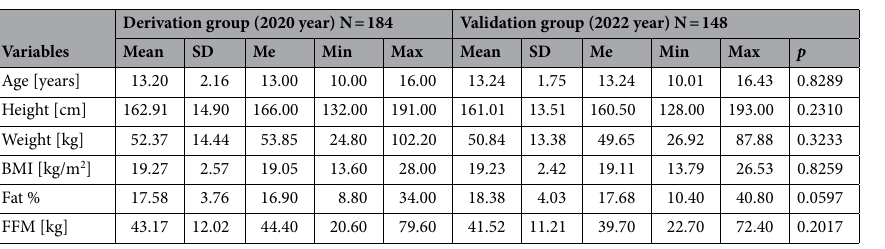
Table 2. Anthropometric characteristics of the study participants. Me median, SD standard deviation, p t Student test, BMI body mass index, FFM fat free mass.